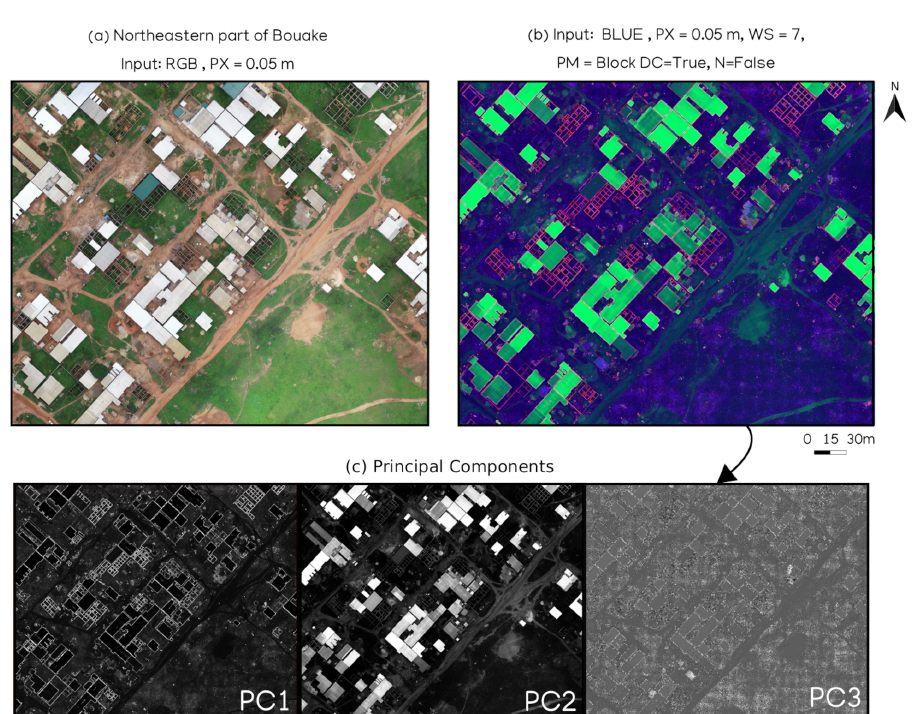
Figure 12. Implementation of the FOTOTEX algorithm on ( a ) a UAV image captured over the city of Bouake ( b ) showing the RGB composite produced by FOTOTEX ( c ) and the three Principal Components. (PX = pixel size, WS = window size, PM = partitioning method, DC = DC component, N =